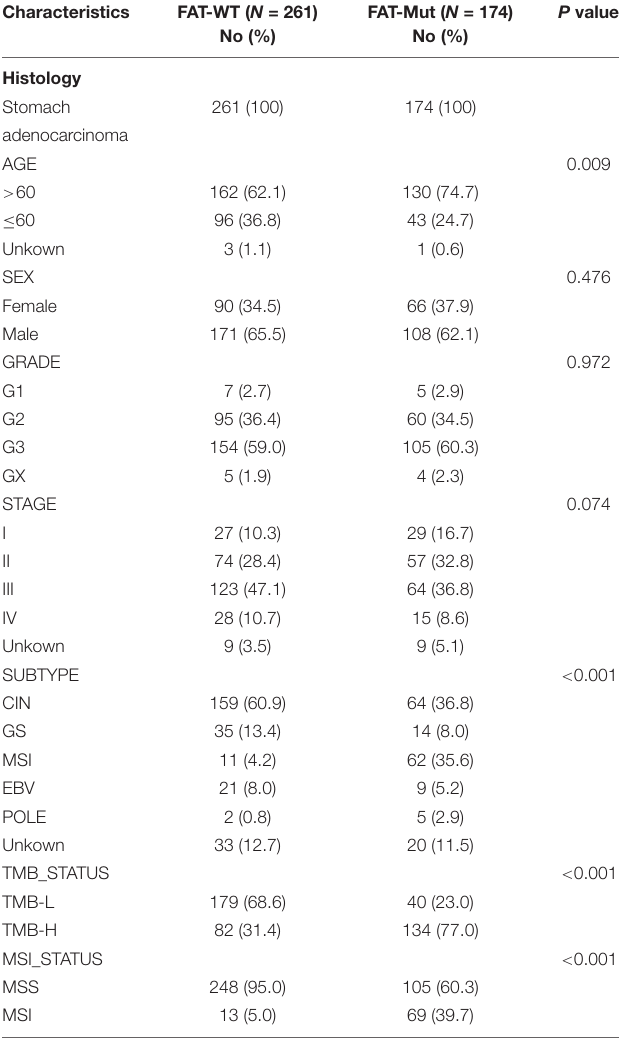
TABLE 1 | The clinical characteristics associated with FAT family genes.